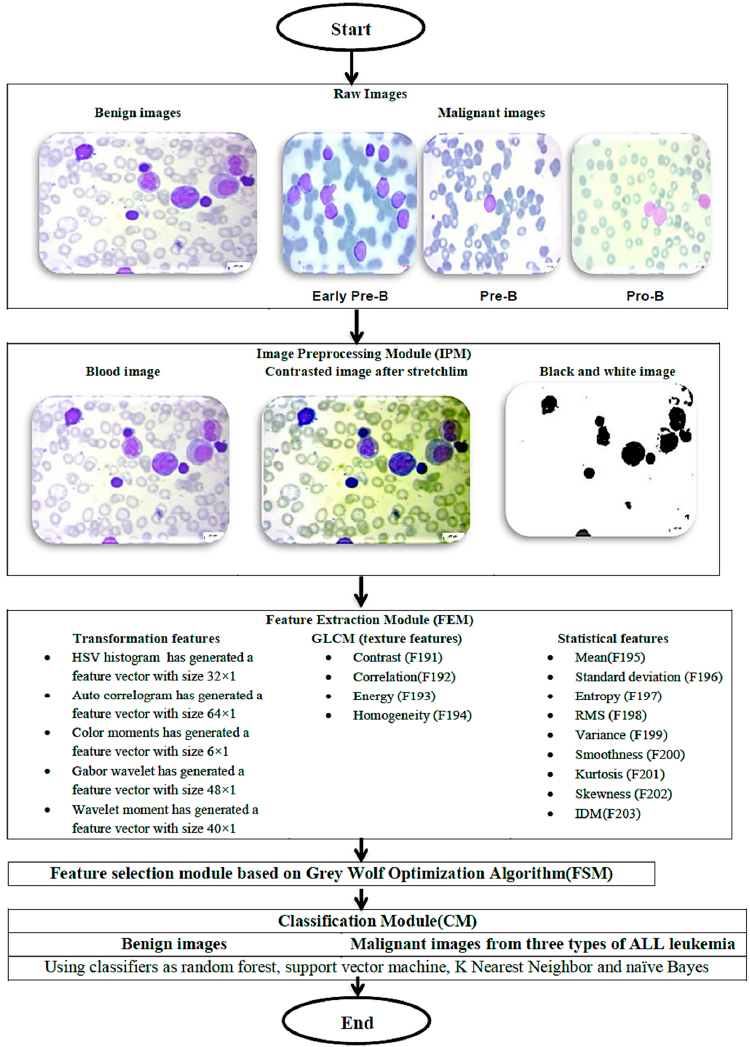
Figure 3. An outline of the suggested